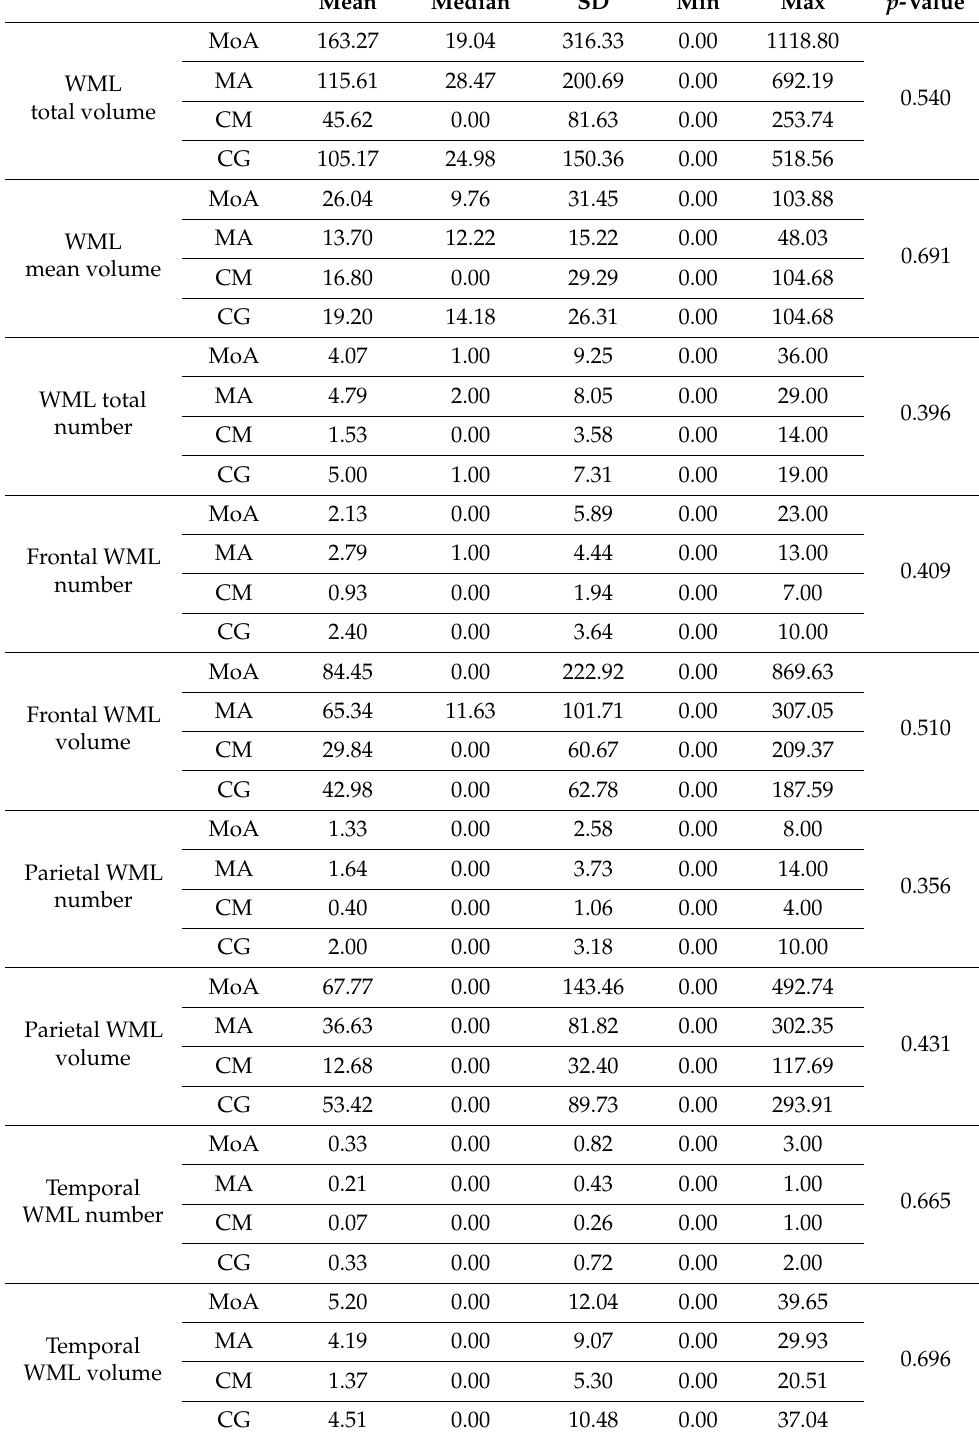
Table 2. Volumetric variables compared between